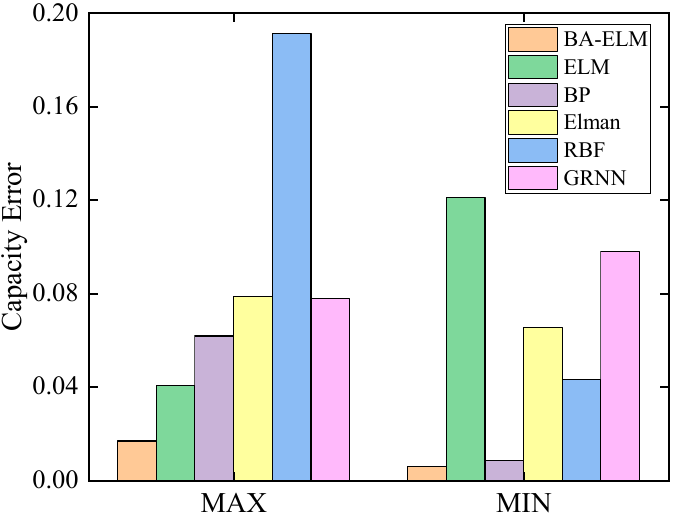
Figure 19. Comparison of MAX and MIN.